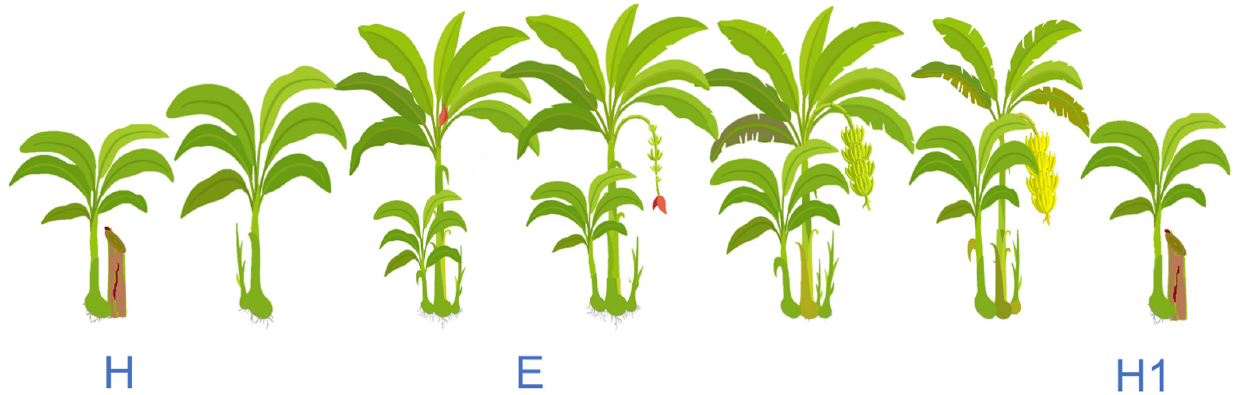
Figure 1. The vegetative life cycle of banana plants with key phenological stages identified for this study, including harvest of the mother plant and establishment of the follower plant ( H ), flower emergence ( E ), and final harvest ( H1 ).